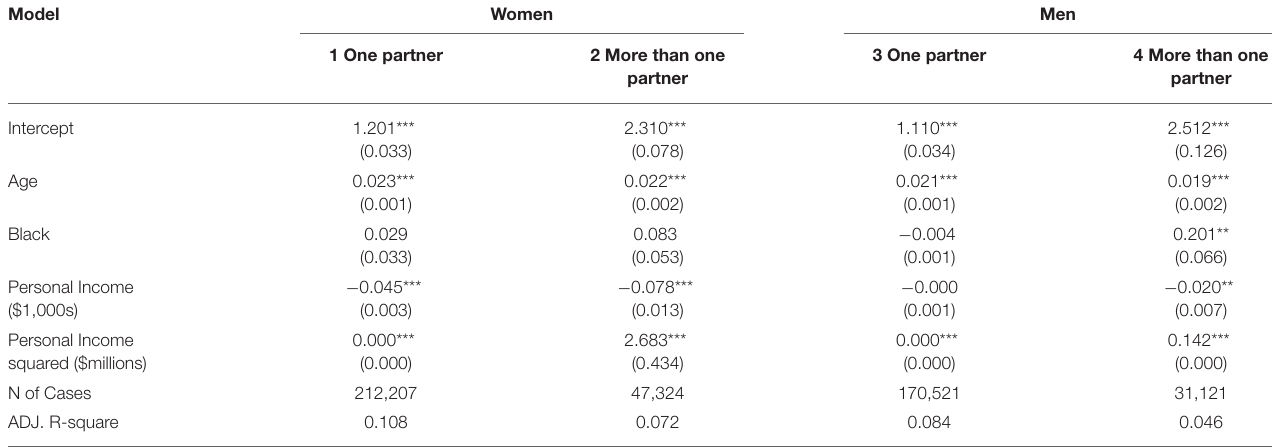
TABLE 5 | Total number of children ever born, by income and income-squared, only those with at least one childbearing partner.